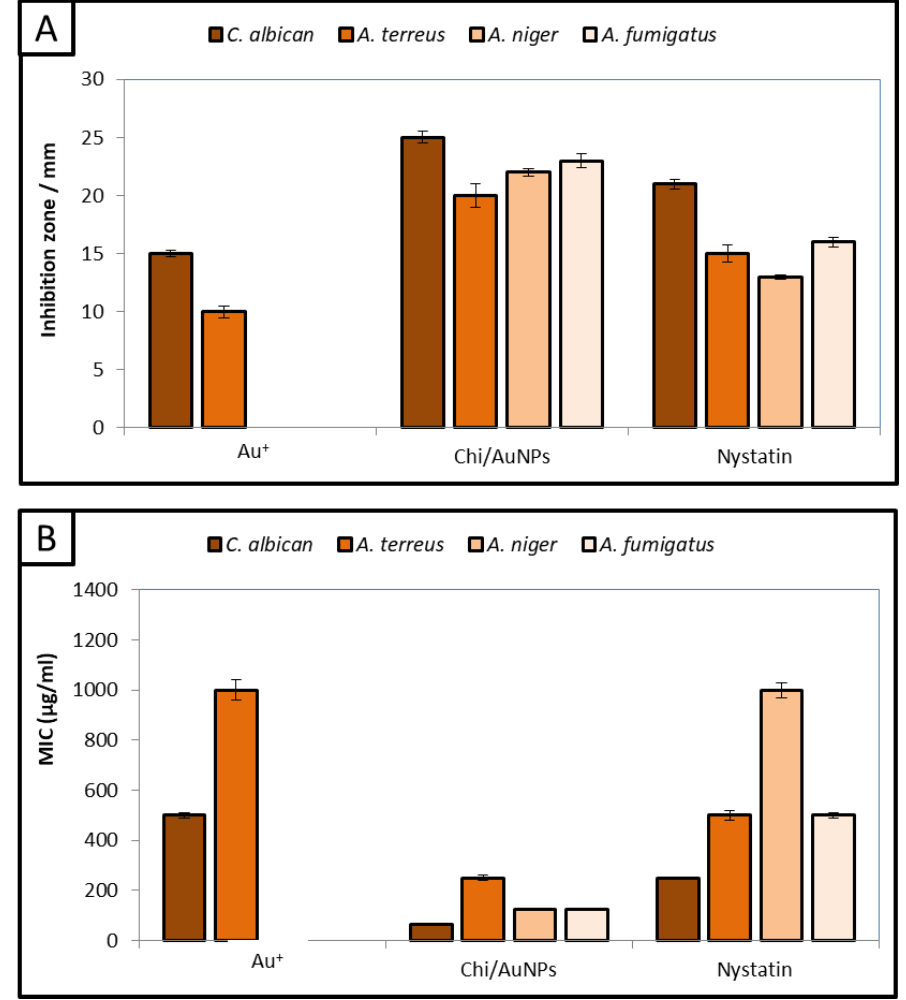
Figure 7. Antifungal activity ( A ) and minimum inhibitory concentration ( B ) of Chi/AuNPs, chitosan, HAuCl4.3H2O, and nystatin against C. albicans , A. terreus , A. niger , and A. fumigatus .